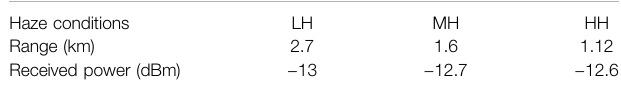
TABLE8| Maximumpropagationrangesandreceivedpowerunderdifferenthaze conditions with log(BER) < − 2.5. Haze